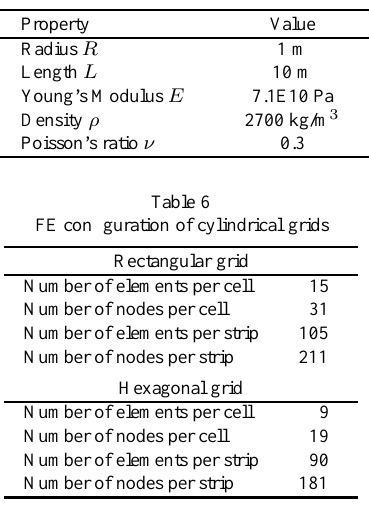
Table 5 Geometry and material properties of cylinder